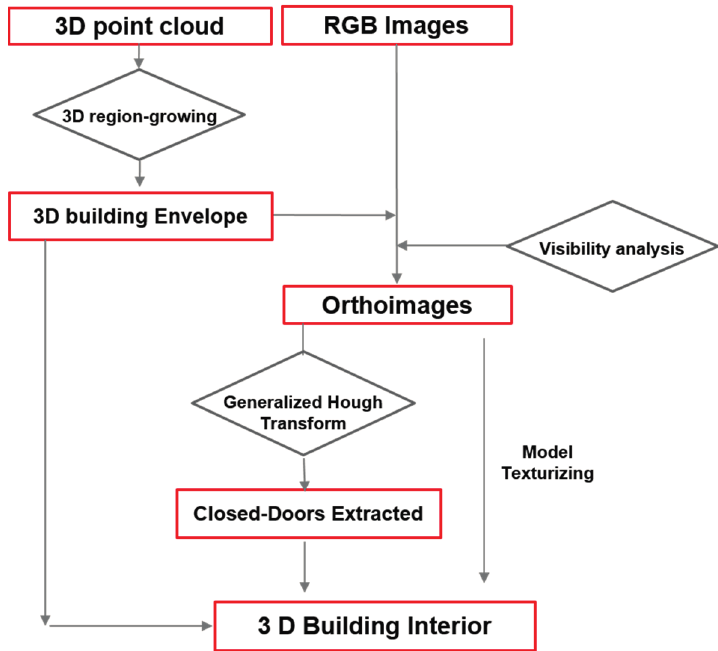
Figure 1. Schema of the proposed methodology for building interior reconstruction.